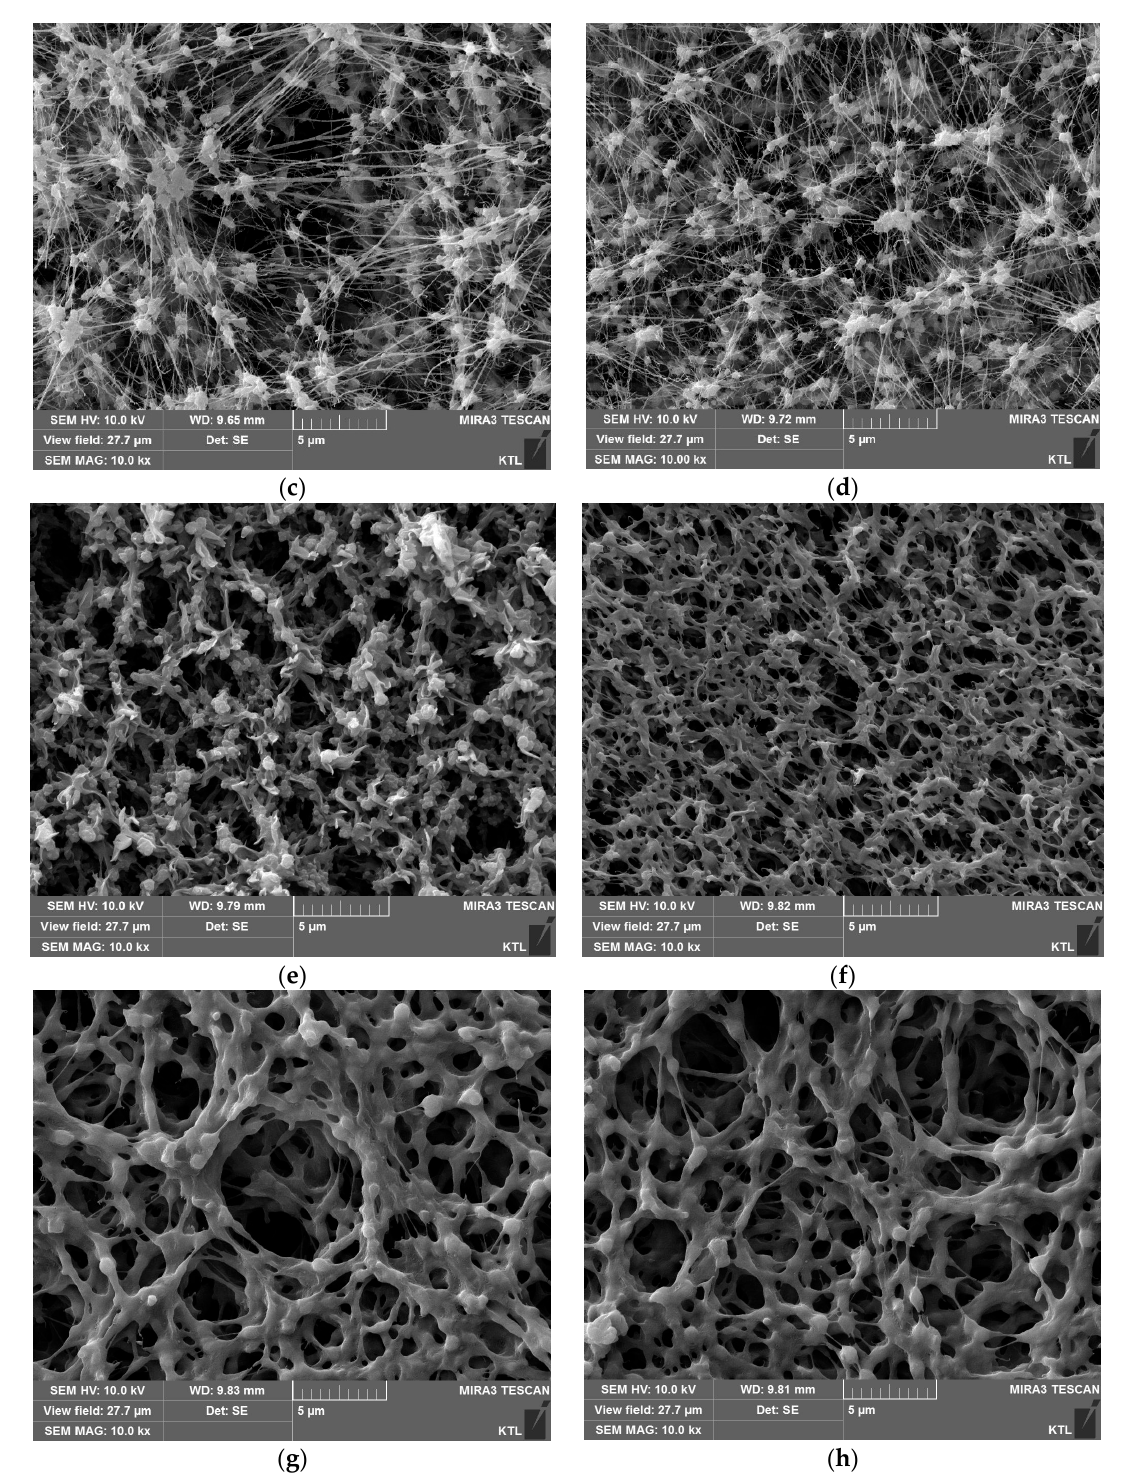
Figure 6. SEM images of polytetrafluoroethylene (PTFE) and PVDF membranes surfaces. The labels ( a – d ) are unpressurized FGLP, pressurized FGLP, unpressurized HVHP and pressurized HVHP, respectively. The labels ( e – h ) are unpressurized FGLP, pressurized FGLP, unpressurized FHLP and pressurized FHLP, respectively. The transmembrane pressure of membrane was set at 30 kPa. Based on the image analysis of SEM images, the pore sizes of the membranes without the pressure were determined as shown in Table 2. The measured pore sizes of the membranes was similar to the nominal pore size provided by the manufacturer: 0.290 μ m (measured, FGLP) vs. 0.20 μ m (nominal, FGLP), 0.420 μ m (measure, FHLP) vs. 0.50 μ m (nominal, FHLP), 0.240 μ m (measured,